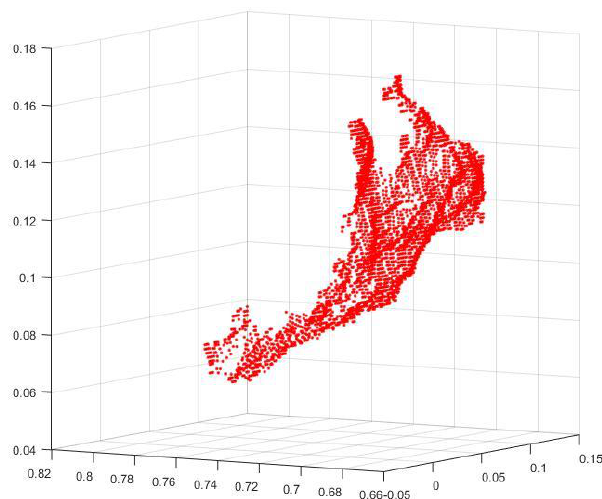
Figure 2. A raw 3D point cloud for Mexican sign language for the letter A. The total number of points is 4061. The X coordinate varies in the range [ − 0.0217, 0.1074], Y in the range [0.0556, 0.1685], and Z in the range [0.67, 0.8]. Notice that the forearm is present.